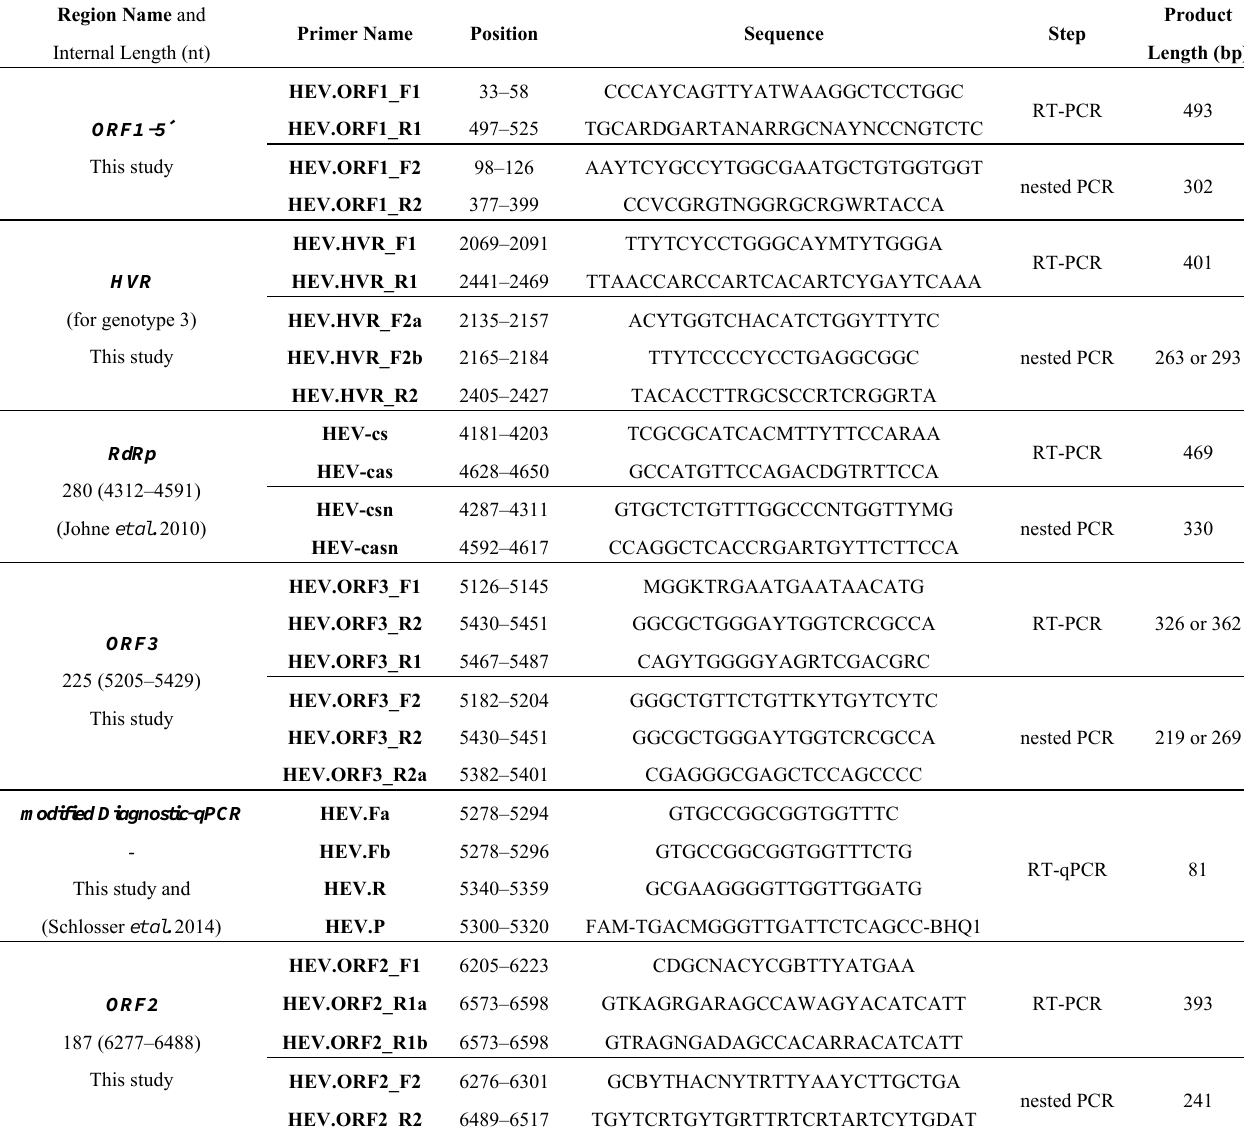
Table 1. Primer and probes used in this study. All nucleotide positions refer to FJ705359 (strain wbGER27, a German wild boar isolate). Abbreviations: open reading frame (ORF), hyper variable region (HVR), RNA dependent RNA polymerase